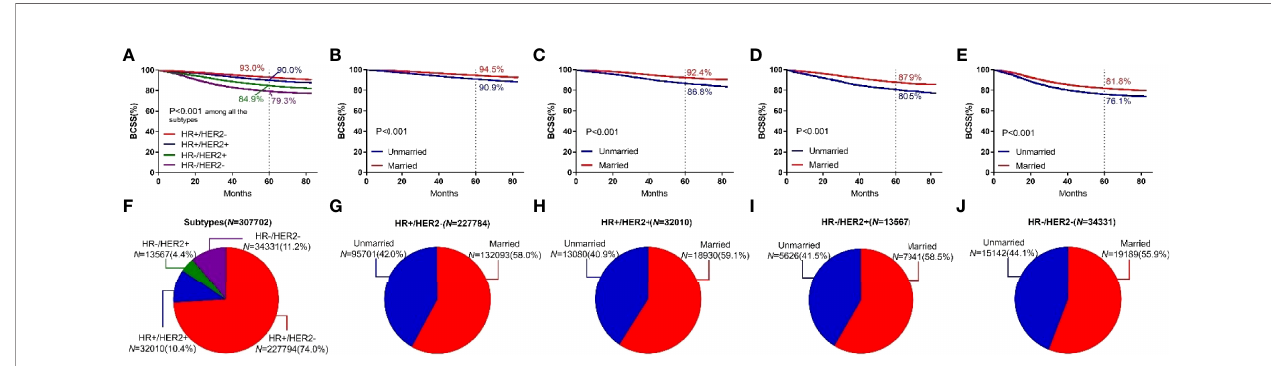
FIGURE 6 | BCSS curves according to the subtypes. (A) and subject proportions of the subtypes (F) . Survival curves of each marital status for HR+/HER2- (B) , HR+/HER2+ (C) , HR-/HER2+ (D) and HR-/HER2- (E) and subject proportions of each marital status for HR+/HER2- (G) , HR+/HER2+ (H) , HR-/HER2+ (I) and HR-/HER2- (J) were depicted.